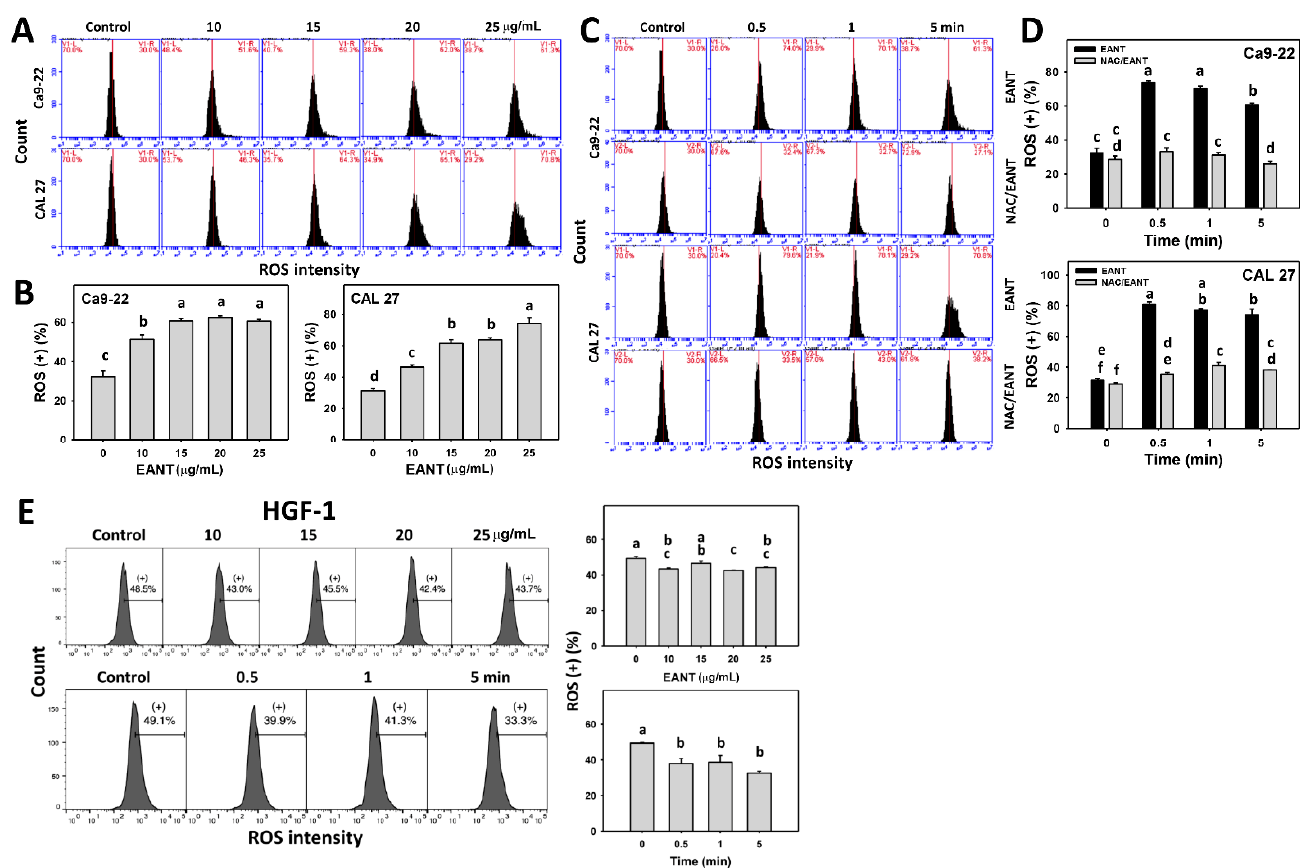
Figure 5. ROS analysis. ( A , B ) ROS pattern and statistical analysis for EANT treated oral cancer cells (CAL 27 and Ca9-22) for 5 min. ( C , D ) NAC (10 mM) pretreatment outcome to ROS patterns and statistical analysis in EANT treatments (0 and 25 µ g/mL) for 0, 0.5, 1, and 5 min. ( E ) ROS pattern and statistical analysis for EANT treated normal oral (HGF-1) cells for different concentrations (0, 10, 15, 20, and 25 µ g/mL for 5 min) and treatment times (25 µ g/mL for 0, 0.5, 1, and 5 min) of EANT. Data (means ± SD, n = 3) showing different letters on-top differ significantly for multiple comparisons ( p < 0.05).